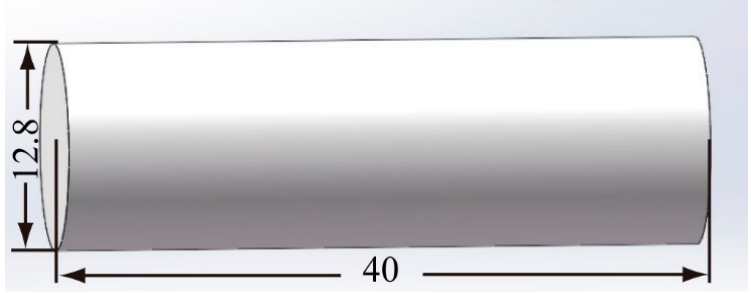
Figure 2. Structure of the blunt projectile.